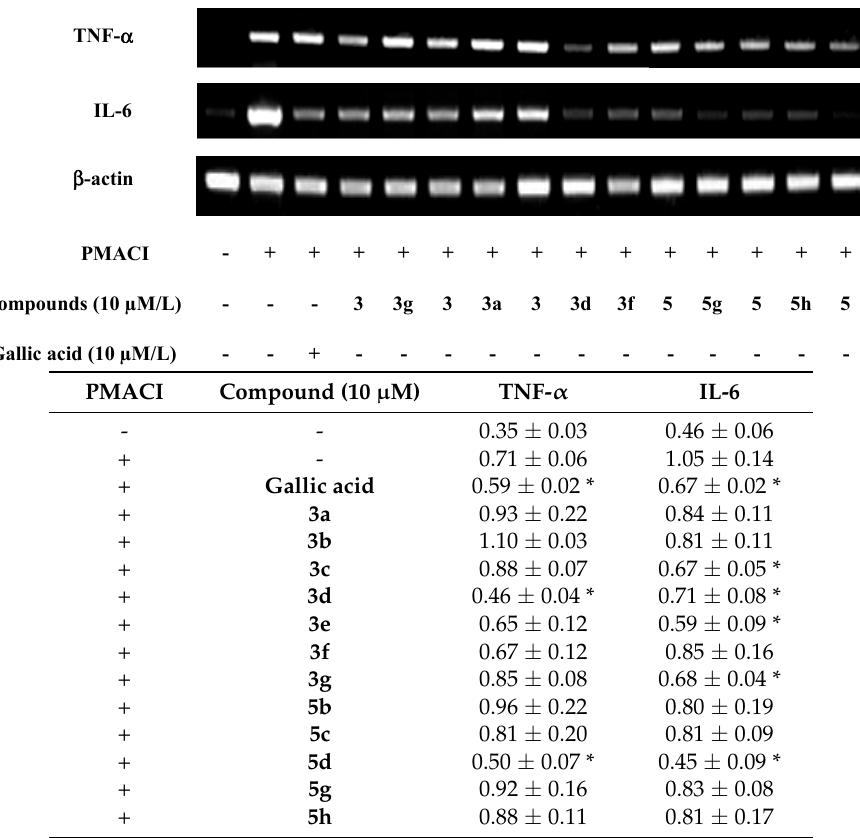
Table 3. Gene expression of pro-inflammatory cytokines. (Values are related to β -actin) * significant inhibition of cytokines.